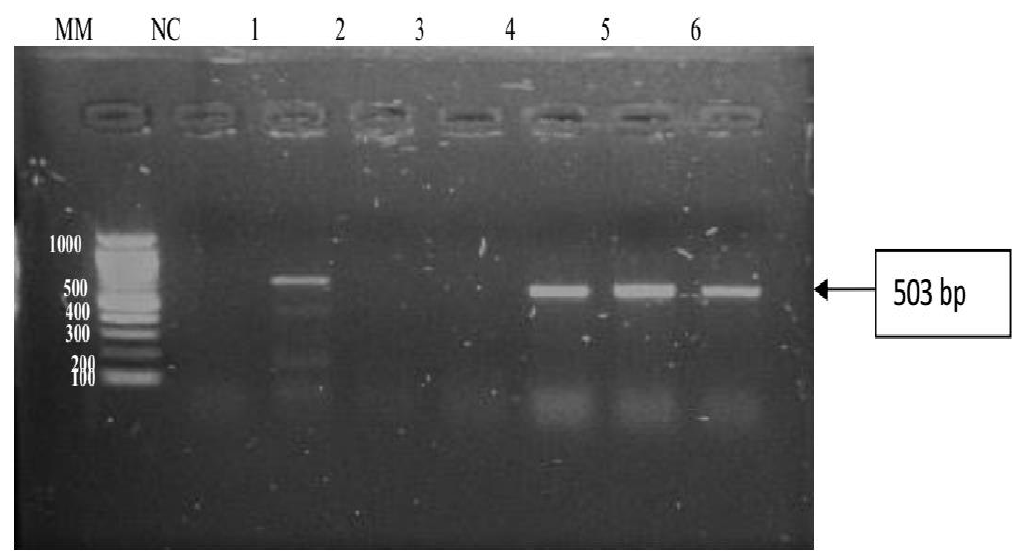
Figure. 2. PCR amplification of tem gene (503 bp). Lane MM: Molecular weight markers 100 bp DNA ladder; Lane NC: Negative control; Lane 1, 4- 6: Positive samples; Lanes 2 & 3: Negative